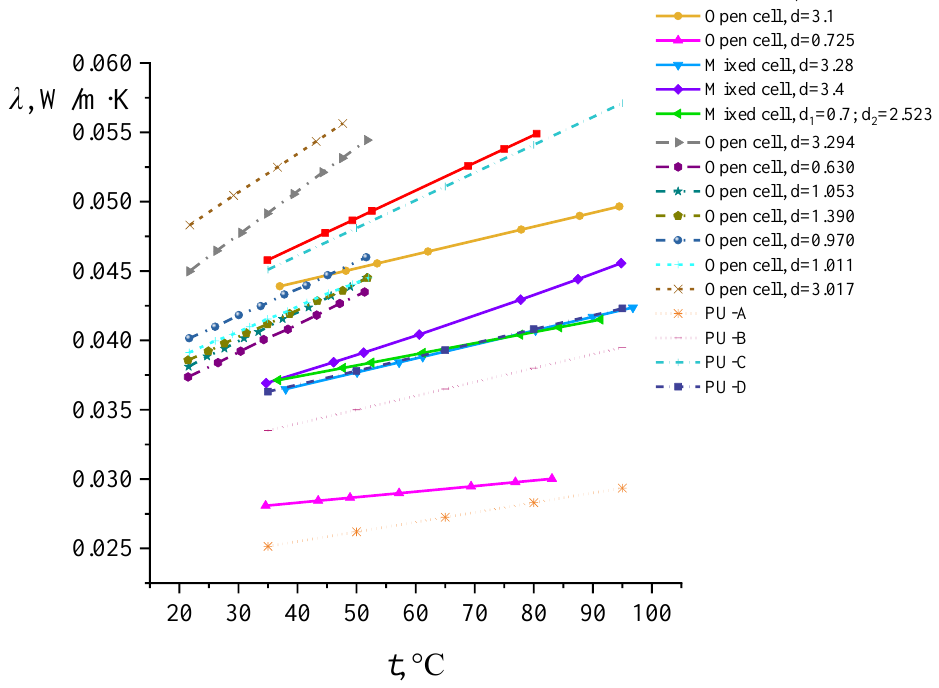
Figure 4. Comparison of graphs of thermal conductivity versus temperature from our work (solid lines) with that of Alvarez-Lainez et al. [27] and Berardi et al. [35] (dashed lines).